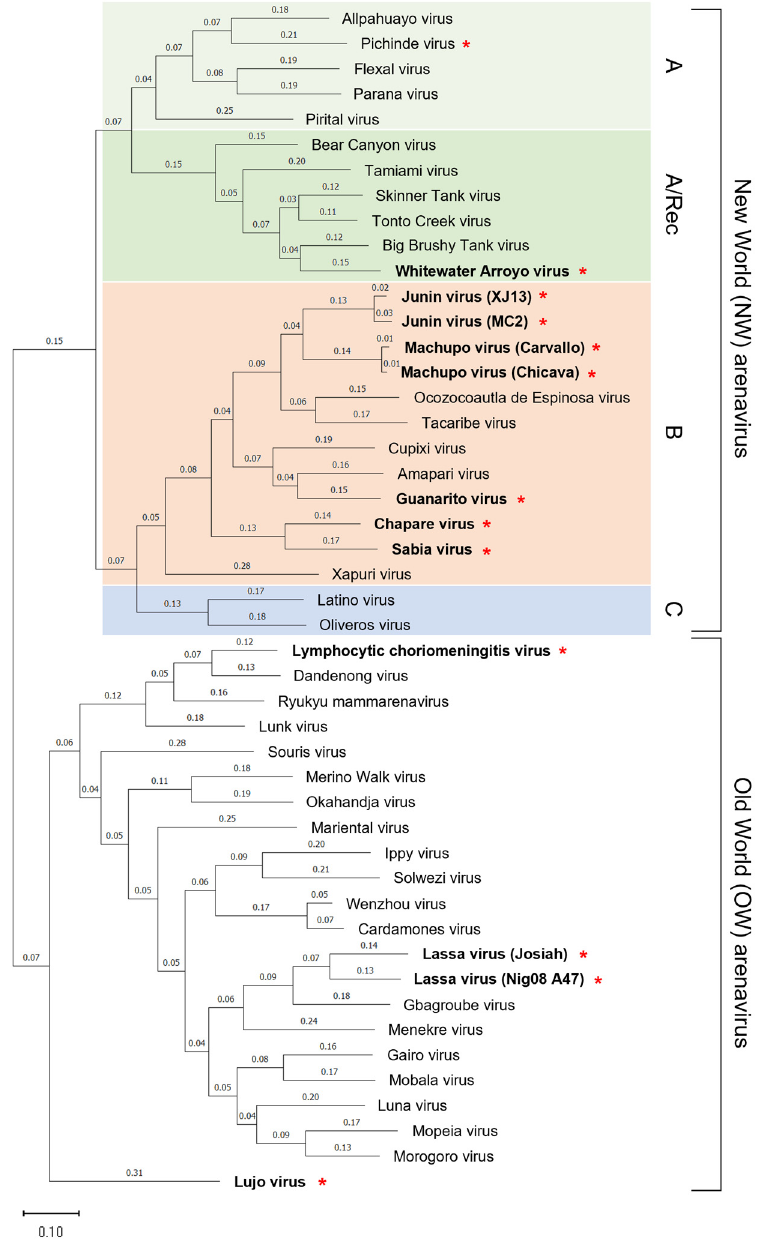
Figure 1. Phylogenetic relationships and classification of arenaviruses. The New World (NW) are- naviruses are subdivided into clade A (light green), clade A/Rec (green), clade B (orange), and clade C (blue). The phylogenetic tree is based on a nucleotide comparison of the NP genes. Red stars following virus names indicates the ability to infect humans. The virus names in boldface indicate Lymphocytic choriomeningitis virus and those that cause fatal hemorrhagic fevers in humans. The phylogenetic tree was drawn using MEGA11: Molecular Evolutionary Genetics Analysis version 1 [24]. The scale bar indicates substitutions per site. Accession numbers for reference sequences are: